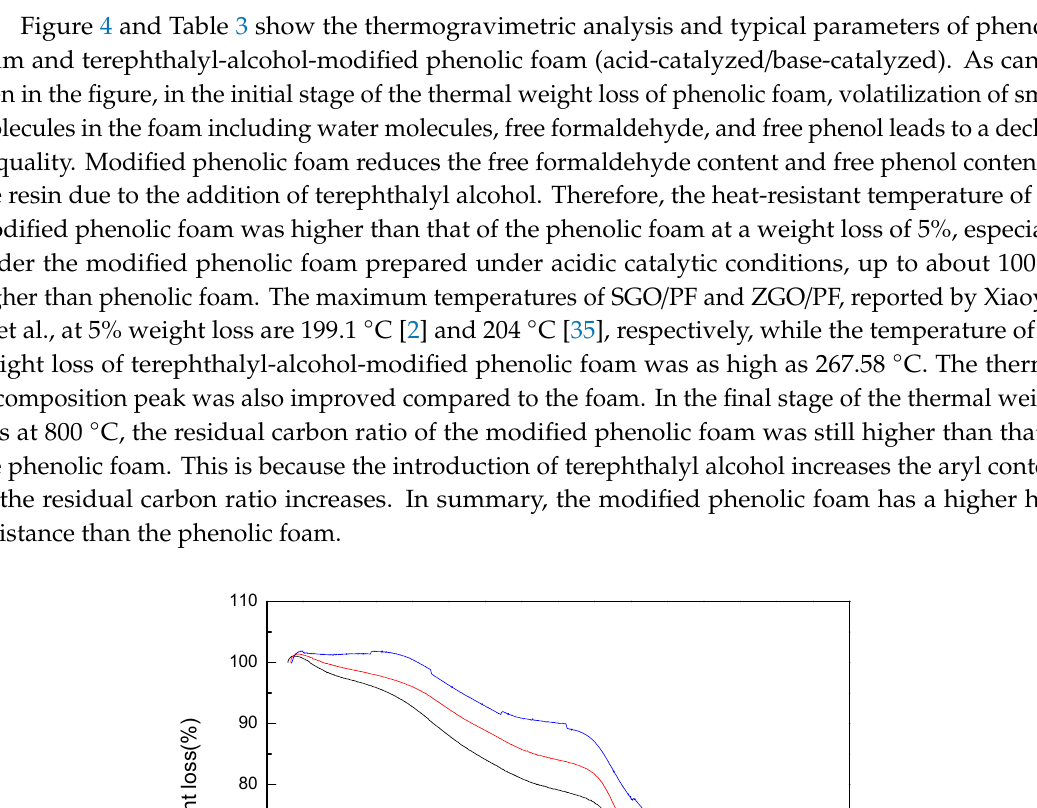
Table 2. Basic properties of resin.